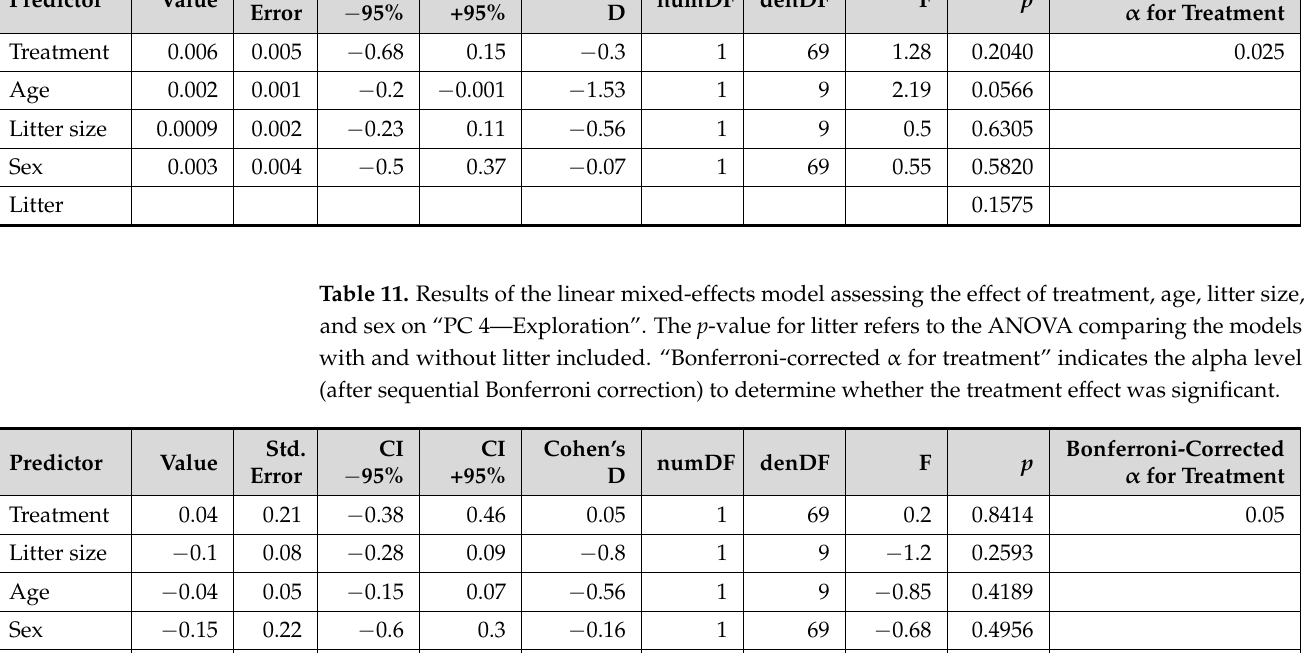
Table 10. Results of the linear mixed-effects model assessing the effect of treatment, age, litter size, and sex on “ PC 2 — Whimpering ” . The p -value for litter refers to the ANOVA comparing the models with and without litter included. “ Bonferroni- corrected α for treatment” indicates the alpha level (after sequential Bonferroni correction) to determine whether the treatment effect was significant.